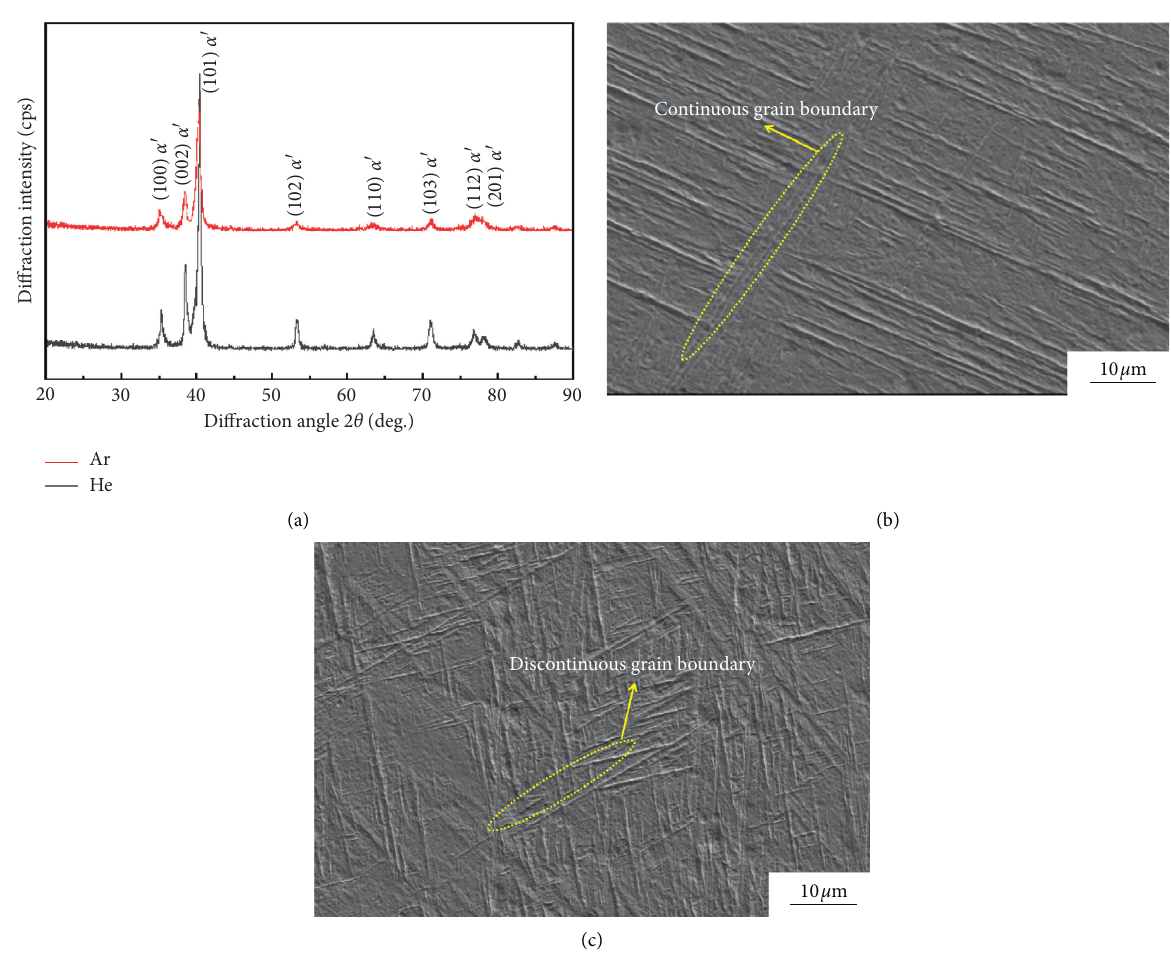
Figure 7: XRD patterns of weld zone (a) and SEM images of weld zone with different shielding gas: (b) Ar and (c)